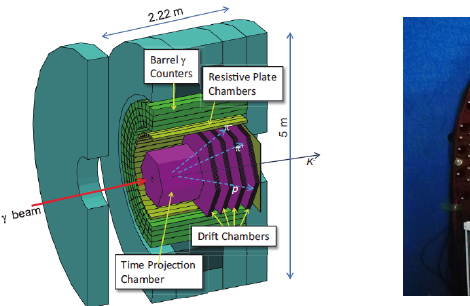
Figure 3. (Left) Schematic drawing of the LEPS2 solenoid spectrometer. (Right) Photograph of the Time Projection Chamber (TPC) and three Drift Chambers (DCs) just before being installed inside the solenoid